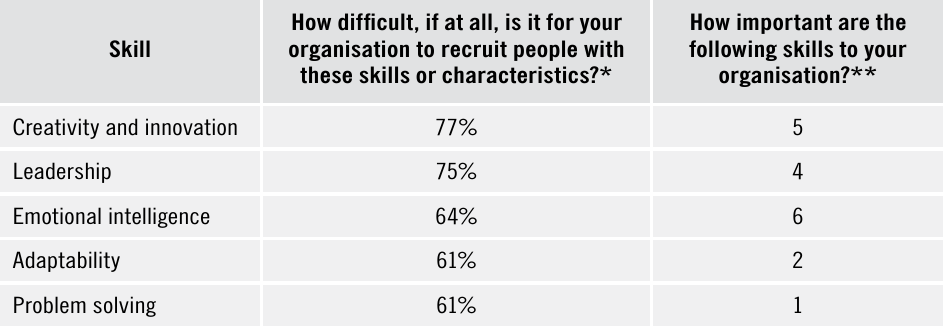
Table 1. Skills CEOs want to find in employees How difficult, if at all, is it for your Skill